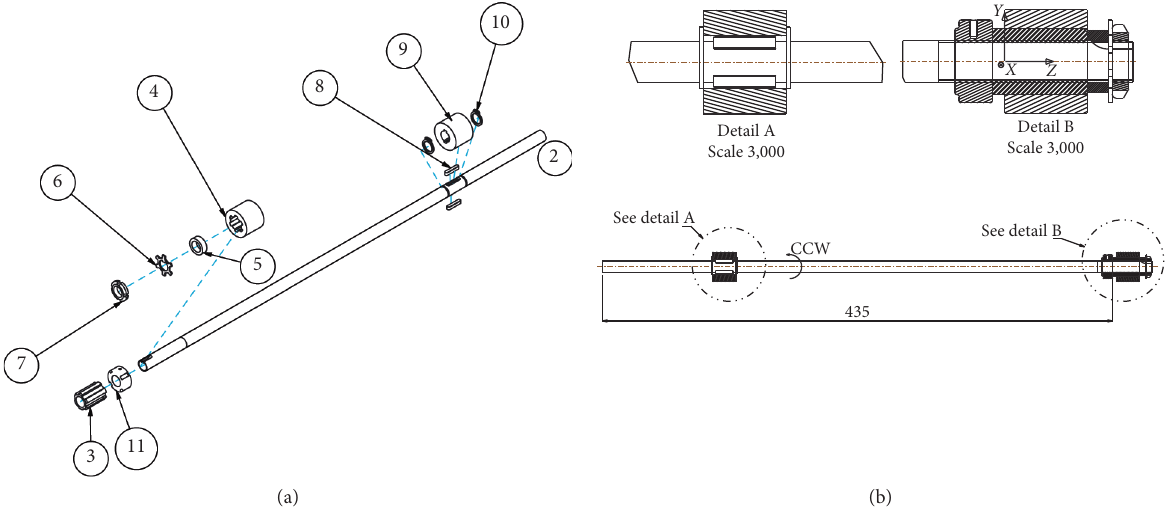
Figure 2: Shaft designed for the modified RK: (a) exploded view and (b) section. The following components are shown: (2) shaft; (3) splined connection; (4) splined hub (journal 1); (5) spacer; (6) safety washer; (7) threaded locking nut; (8) key; (9) hub with keyways (journal 2); (10) retaining ring; (11) lock nut with locking screw. Table 1: –Original-modified RK design